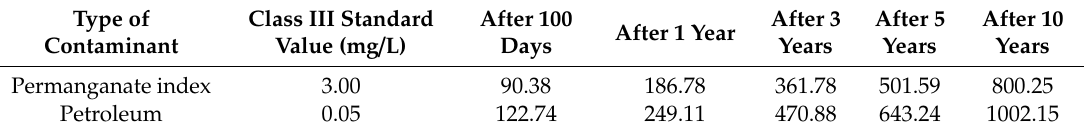
Table 7. Results of prediction of excessive di ff usion distance under abnormal conditions